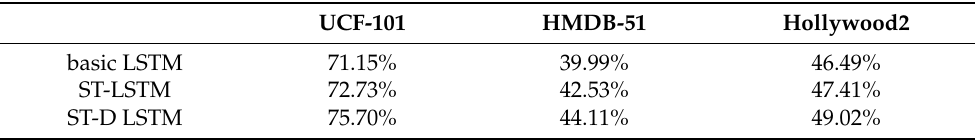
Table 1. The accuracy of different LSTM units on three datasets.